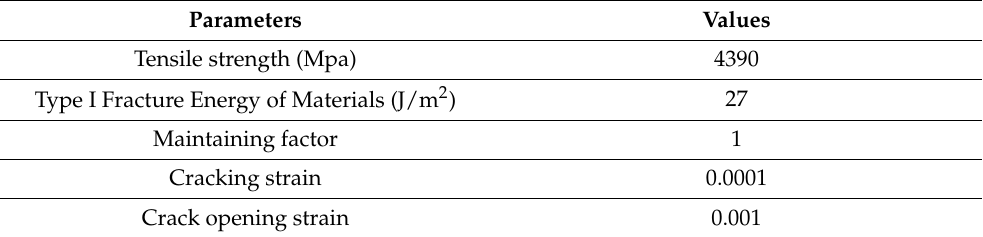
Table 3. Material properties of TiC